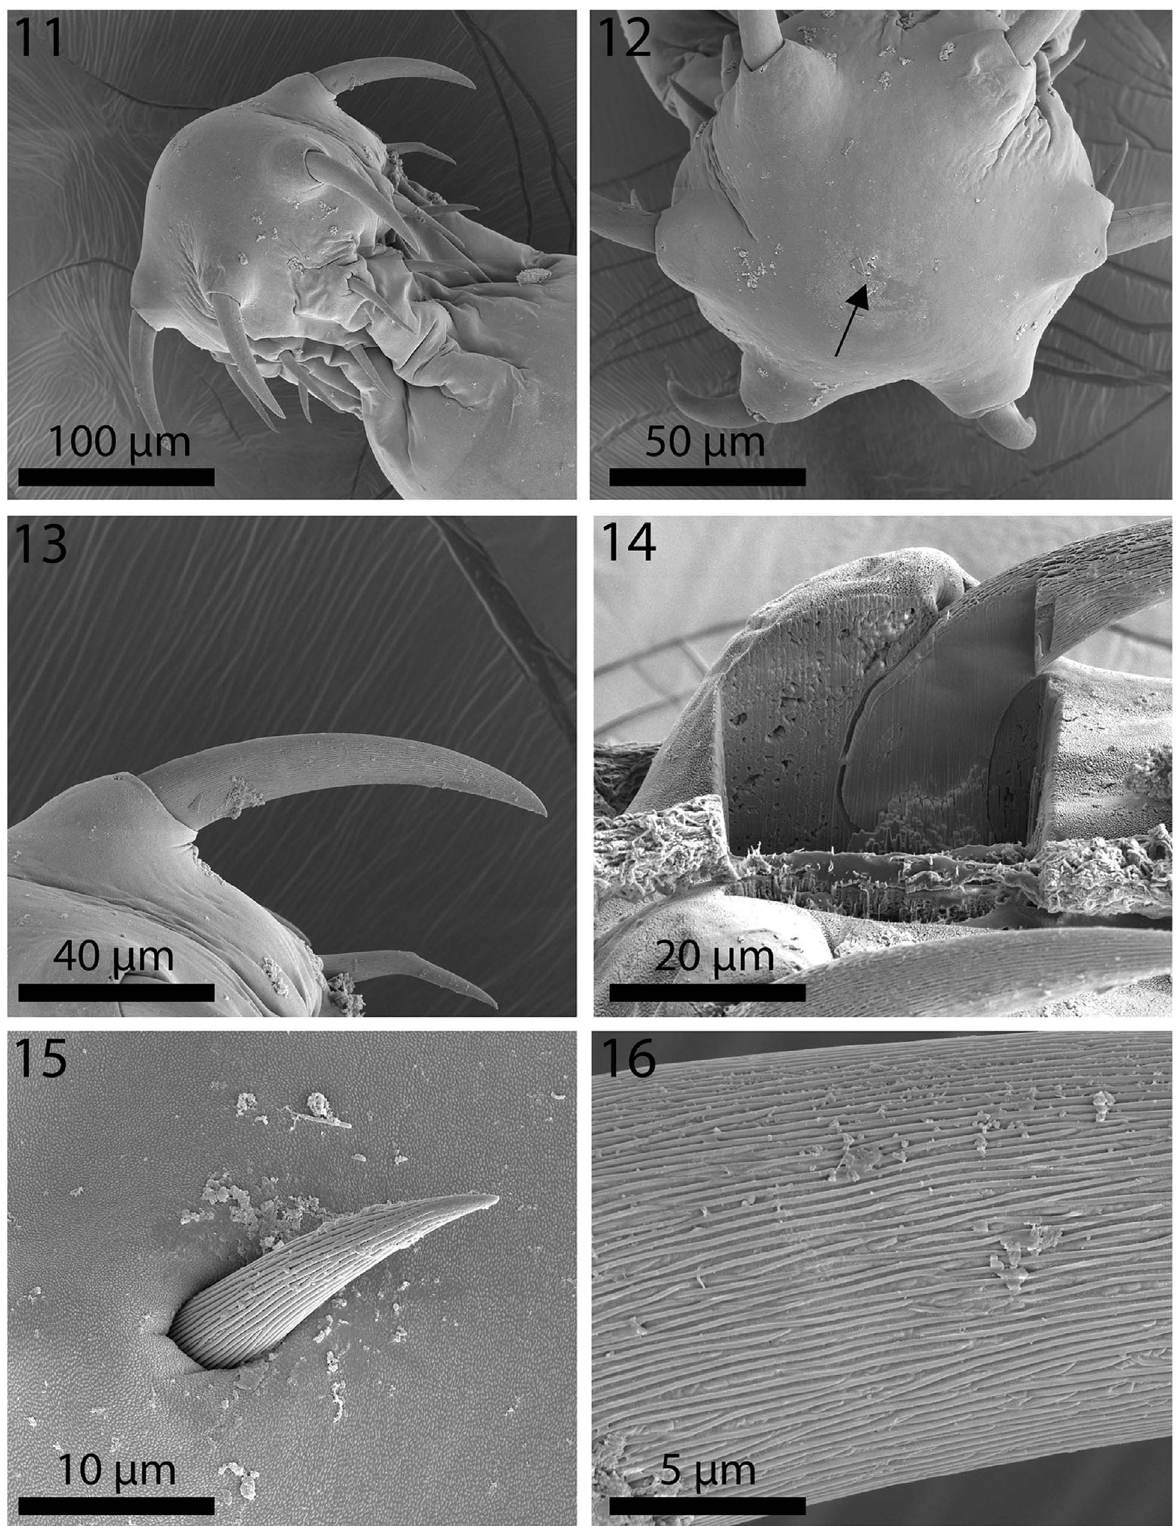
Figures 11 – 16. SEM of specimens of Neoechinorhynchus personatus from Mugil cephalus in the Mediterranean Sea off Tunisia. 11. Proboscis of a male specimen showing the large anterior hooks and the delineation of the neck. 12. An apical view of a proboscis showing the pore of the apical organ (arrow). 13. The magni fi ed anterior and middle hooks of the proboscis shown in Fig. 11. 14. A partially Gallium cut anterior hook showing its thin cortical layer and dense core, and its articulation vs. the root of the same core density. 15. The longitudinal serrations on the posterior hook are evident. 16. A magni fi ed view of an anterior hook depicting the pattern of the